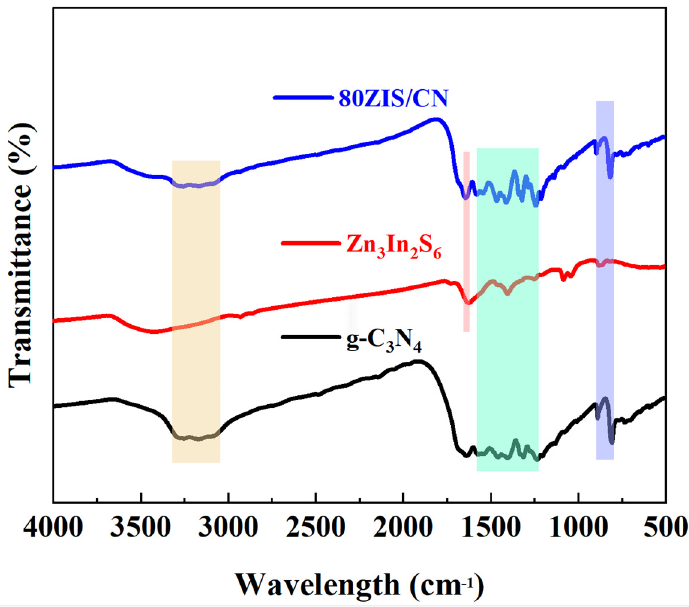
Figure 5. PL spectra: g ‐ C 3 N 4 , Zn 3 In 2 S 6 and 80ZIS/CN heterojunction.